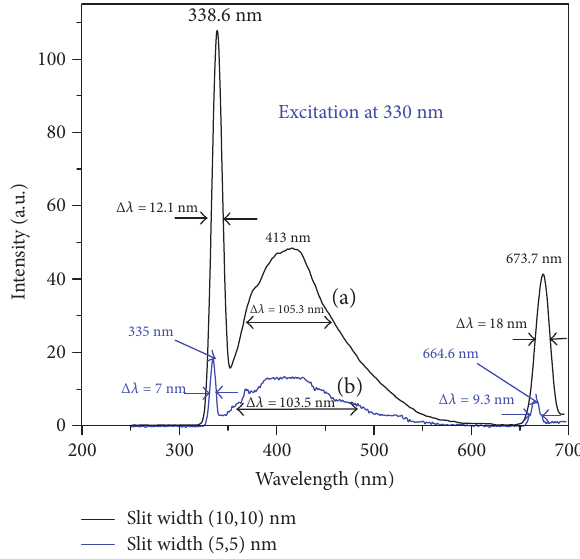
Figure 4: Rayleigh scattering and fl uorescence signal with di ff erent slit widths (for acetone). (a) Black line and (b) blue